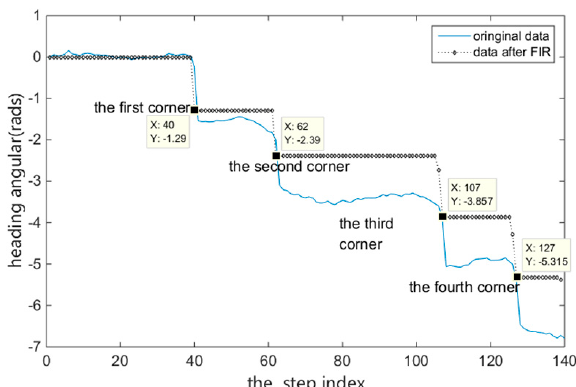
Figure 7. Illustration of the trend diagram of 𝑟 (cid:3040)(cid:3047),(cid:3038) . Firstly, from step 𝜅 = 1 to step 𝜅 = 40 (the first corner), the user moved from the south to the north. During this phase, the distance from the east wall and the west wall should remain unchanged, the distance from the south wall should be increasingly larger, and the distance to the north wall should be increasingly smaller. Thus, the trajectory trend when 1 ≤ 𝜅 ≤ 40 was gentle for 𝑘 = 1 and 𝑘 = 3 , increasing for 𝑘 = 2 , and decreasing for 𝑘 = 4 . Next, the user moved from the west to the east; that is, from the first corner ( 𝜅 = 40 ) to the second corner ( 𝜅 = 62 ). During this phase, the distance from the south wall and the north wall should remain unchanged, the distance from the west wall should increase, and the distance to the east wall should decrease. Thus, the trajectory trend when 40 ≤ 𝜅 ≤ 62 is gentle for 𝑘 = 2 and 𝑘 = 4 , increasing for 𝑘 = 1 , and decreasing for 𝑘 = 3 . Similarly, the trends of the distance changes for other sections were the same as the changes in the actual distances. However, the change parts marked with the black dotted rectangles at every corner point in Figure 7, which should be the smooth transition curves, become sudden sharp declines. After repeating the measurements, we think that the reason for this change is the remaining accumulated errors of the heading angle 𝜃 due to the assumption that the experimenters in this study walked strictly along the dominant directions. In fact, the randomness of a person’s walking causes their direction of travel to deviate from the dominant direction, and this error is also eventually reflected in the trajectory of the position tracking.